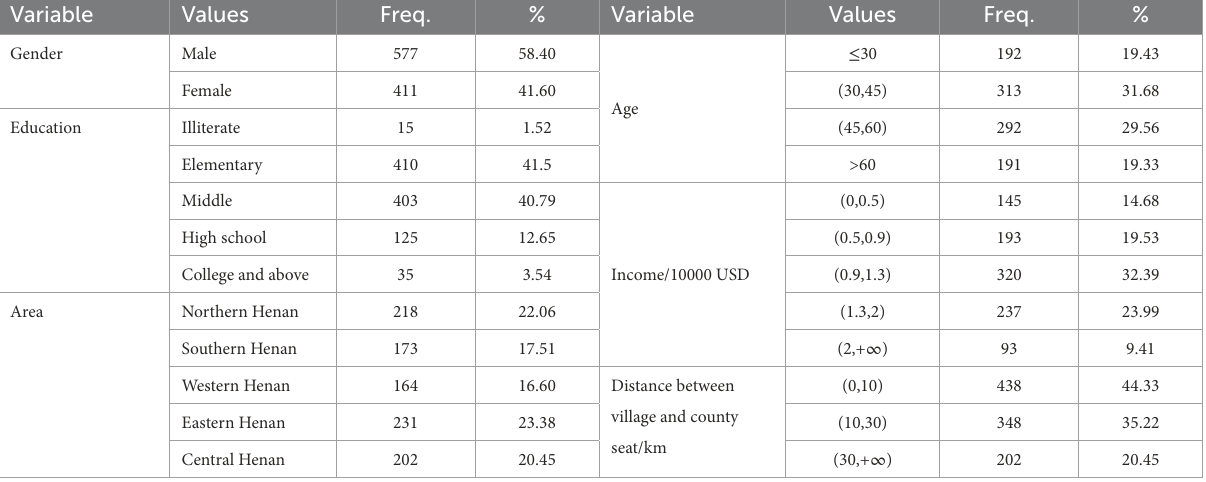
TABLE 1 Sample basic